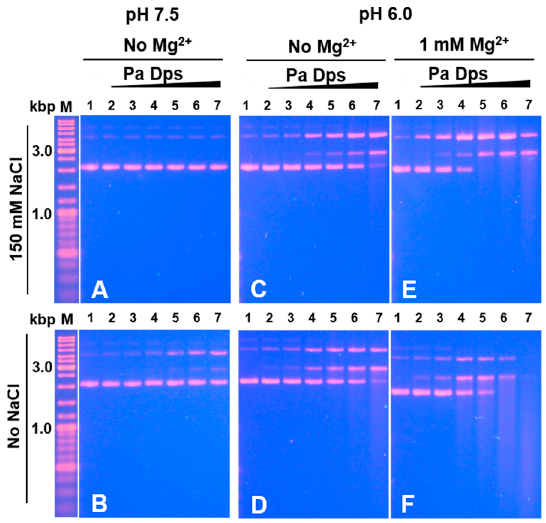
Figure 10. DNA cleavage requires 12-mer Pa Dps and divalent ions. Protein and pUC18 DNA plasmid (8.6 nM) were incubated in mole ratio Pa Dps:DNA = 5, 10, 50, 100, 200, and 400 (lanes 2–7, respectively) and the following conditions: ( A ) 75 mM Tris pH 7.5 and 150 mM NaCl, ( B ) 75 mM Tris pH 7.5, ( C ) 75 mM Bis-Tris pH 6.0 and 150 mM NaCl, ( D ) 75 mM Bis-Tris pH 6.0, ( E ) 75 mM Bis-Tris pH 6.0, 150 mM NaCl and 1mM MgCl 2 , and ( F ) 75 mM Bis-Tris pH 6.0 and 1 mM MgCl 2 . Lane 1 = DNA, M = DNA ladder.